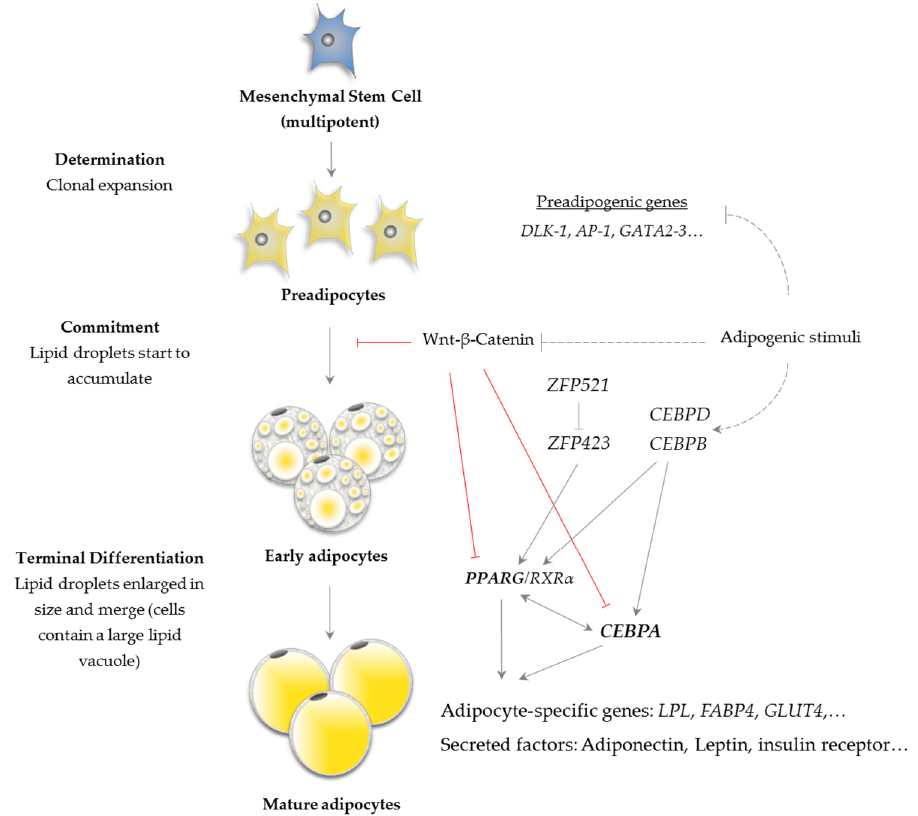
Figure 4. Schematic representation of the transition process from mesenchymal stem cell to mature adipocytes and transcriptional cascade during adipogenesis [38]. DLK-1 = delta-like 1 homolog ; AP-1 = activator protein-1 ; GATA2 and 3 = GATA-binding proteins 2 and 3 ; WNT = wingless-type MMTV integration site family members ; ZFP423 = zinc finger protein 423 ; CEBPA , B and D = CCAAT / enhancer-binding protein alpha, beta and delta; PPARG = peroxisome proliferator-activated receptor gamma ; RXRA = retinoic X receptor alpha ; LPL = lipoprotein lipase ; FABP4 = fatty acid-binding protein 4 and GLUT4 = glucose transporter type 4 .